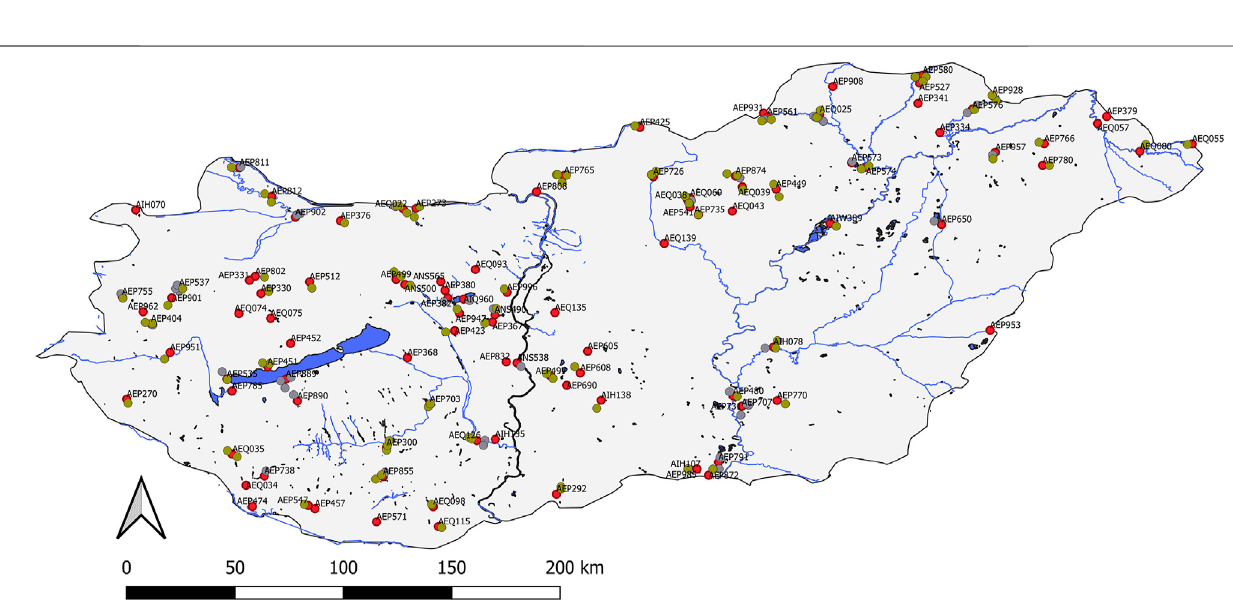
Figure 12 represents the global annual change in physical- chemical water quality parameters. The labelling of each water quality parameter is indicated in this fi gure. On the upper plot, the vertical axis shows how good the parameters are. Four